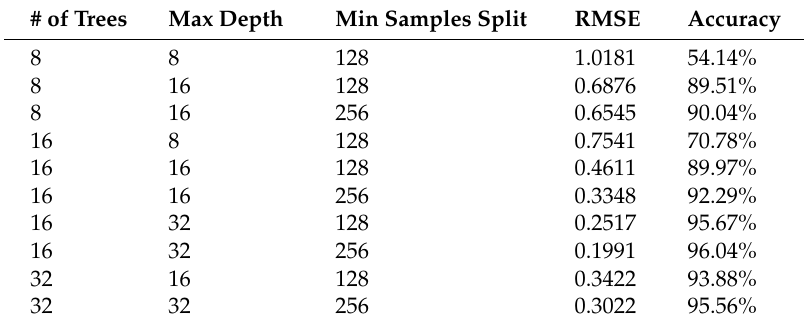
Table 3. Detailed regression and classification results of the Random Decision Forest models. Each model uses a different number of trees, maximum depth, and minimal sample split (first three columns).